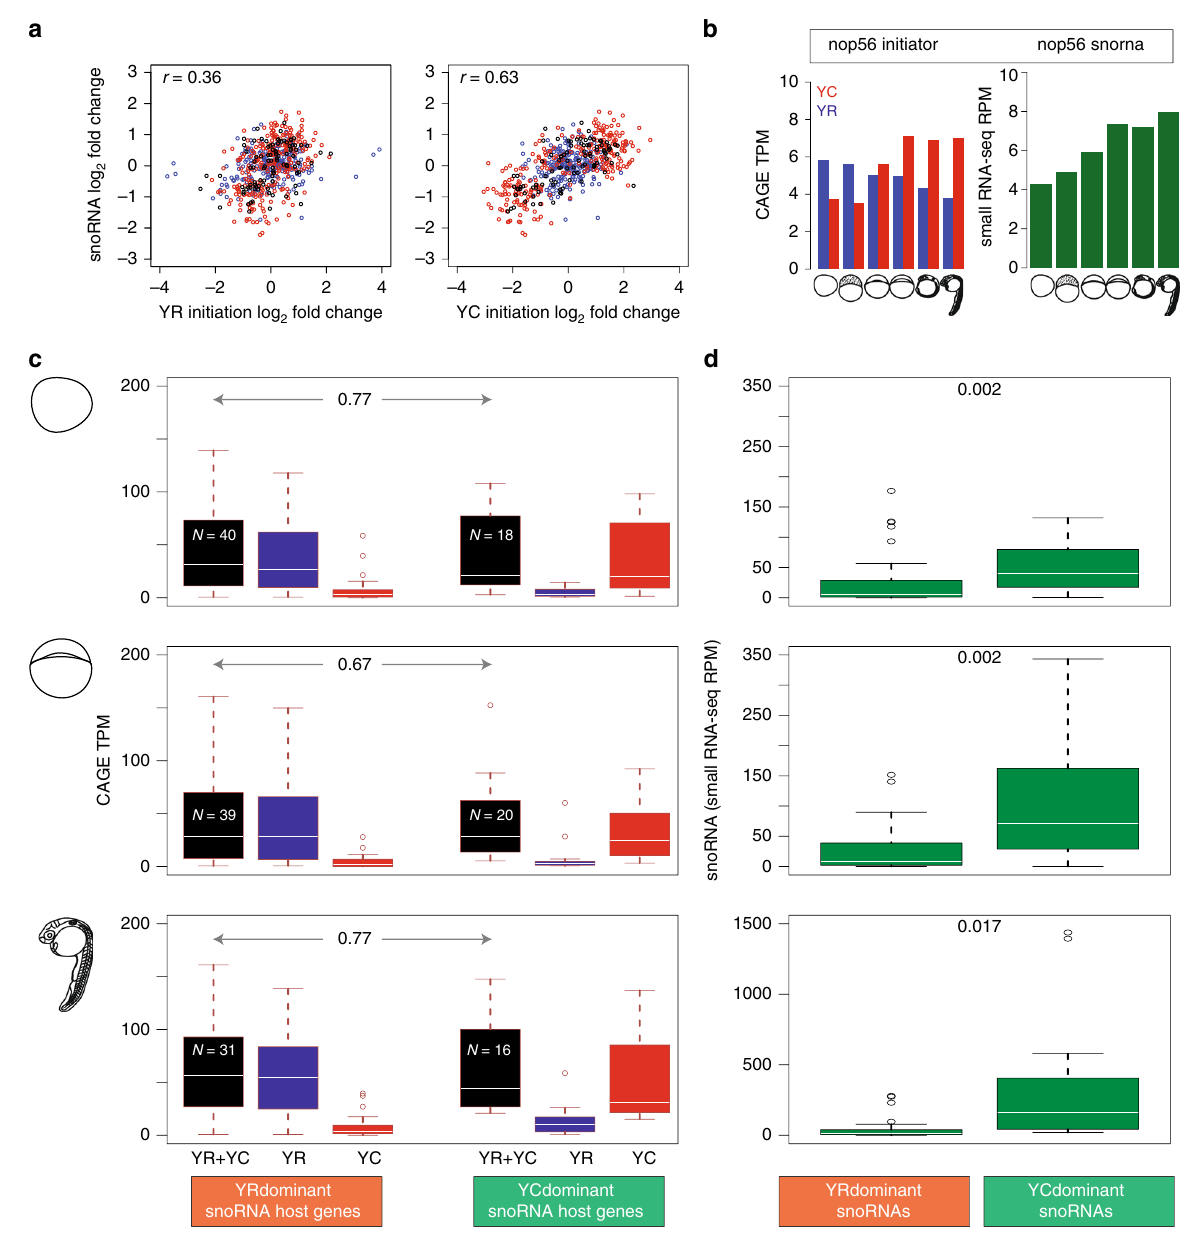
Fig. 4 Correlation of expression levels of YR and YC components of snoRNA host genes with that of snoRNA expression levels. a Scatter plot of correlations between snoRNA log fold changes with YR-initiation log fold changes (left), and with YC-initiation log fold changes (right) across six developmental stages among 94 dual-initiation snoRNA host genes. Each point corresponds to one stage-gene pair of YR-dominant transcripts (blue), YC- dominant transcripts (red) and the rest (black). b Bar plot of CAGE expression levels (tpm) of YR (blue) and YC (red) components of initiation at the nop56 gene. Expression levels of snoRNA (dark green) were calculated from small RNA-seq data in reads per million. c Box plot of TPM expression levels of YR- initiation (blue), YC-initiation (red), and total (black) of YR-dominant and YC-dominant snoRNA host genes selected for comparable total expression level are shown. The number of YR-dominant and YC-dominant snoRNA host genes are denoted by “ N ” . d Box plot of expression levels of corresponding snoRNAs (green) from YR-dominant and YC-dominant host genes shown in d . Developmental stages are fertilized egg, 30% epiboly and prim 5 stages (top to bottom) are depicted on the left. Boxplots show the 5th, 25th, 50th, 75th, and 95th percentiles where center line is the